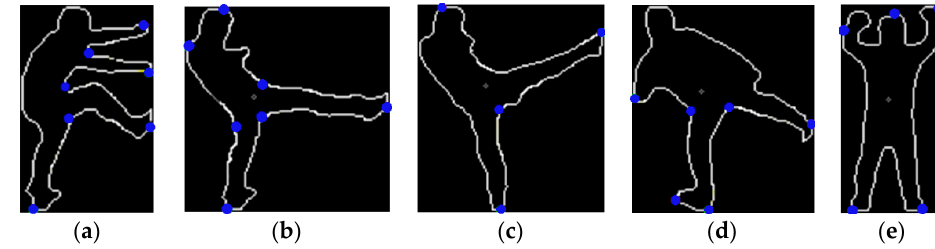
Figure 17. Examples of cases in which the convexity defect-based method produced an erroneous recognition result. ( a – d ) Kicking; ( e ) waving with two hands.